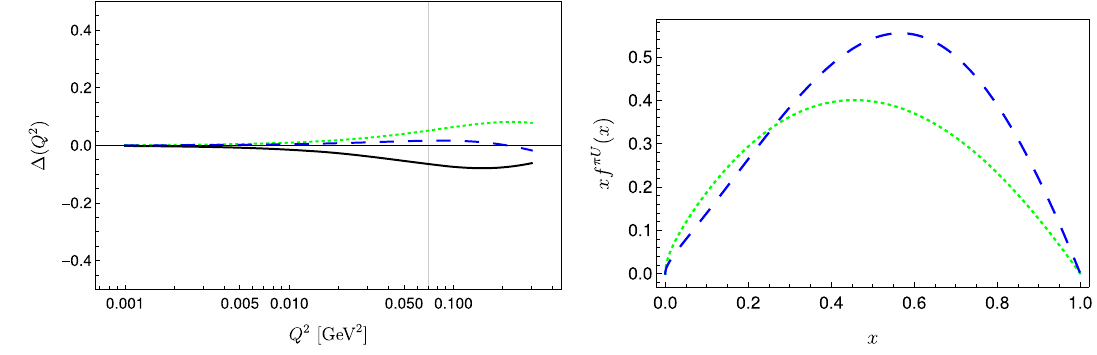
Fig. 13 Same of Fig. 12 but left panel: for the (cid:15)( Q 2 ) function. Right panel: for the pion PDF (cid:17) T =± ( x , b ⊥ ) = h , ¯ h